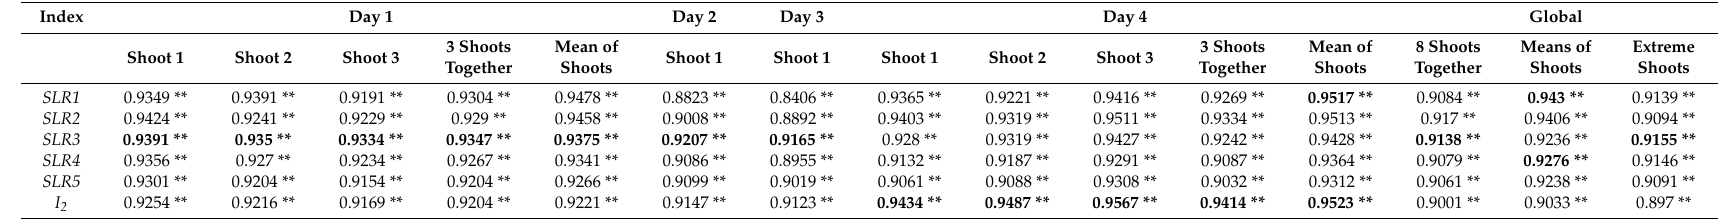
Table 6. Correlation coe ffi cients for new indices obtained by SLR process. Results are given for each individual shoot, for daily values on days #1 and #4 (taking into account the three shoots altogether or the mean values of the three shoots) and for global datasets. The latter include data from all the days using the eight shoots, data from all the days using mean values for days #1 and #4 and mean values between extreme shoots (the darkest shoot from day #1 and the brightest shoot from day #4). The highest R-values are highlighted in bold typeface. Significance level: ** ( p <